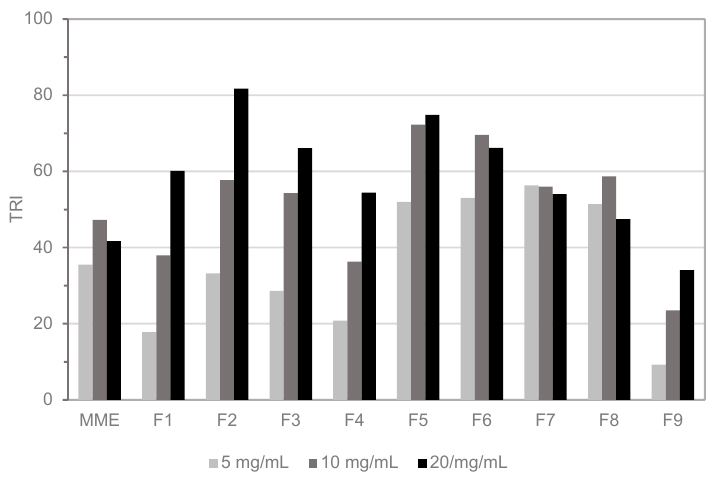
Figure 1. High-throughput screening using dansylated cysteamine (HTS-DCYA) results of myrrh methanol extract (MME) and fractions TRI = total reactive index.